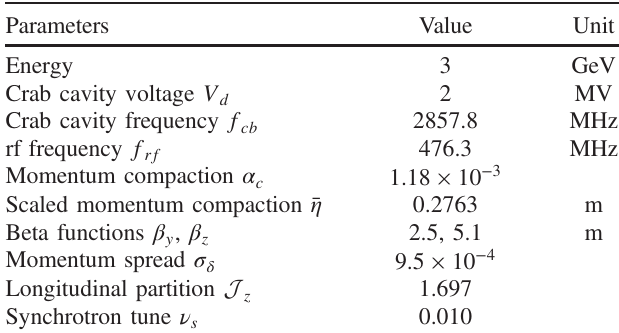
TABLE I. Parameters of simplified model. Parameters